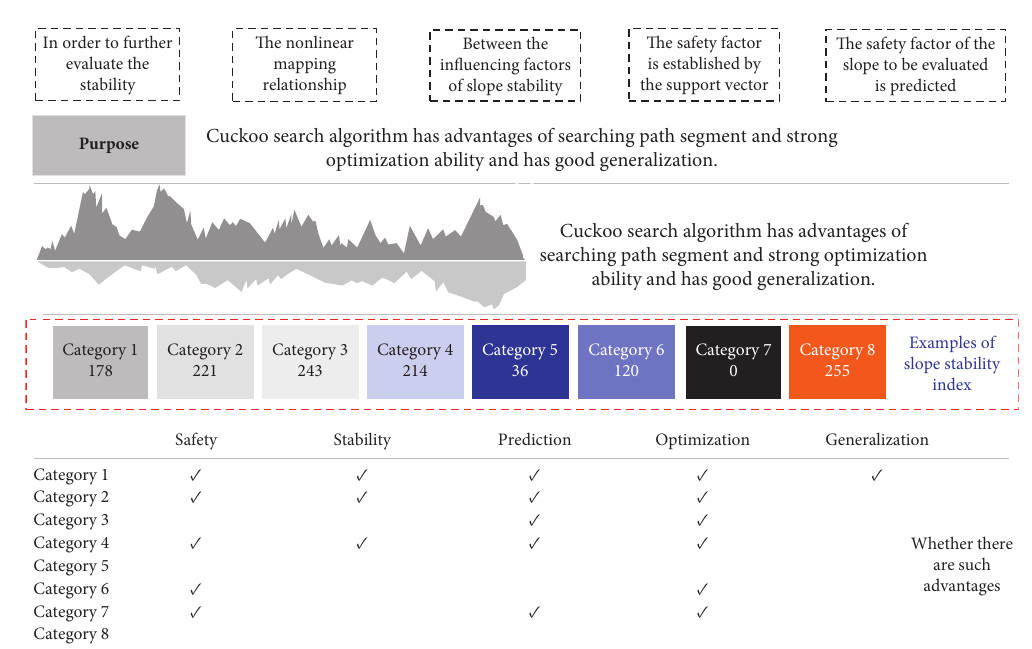
Figure 5: The prediction model and examples of the performance